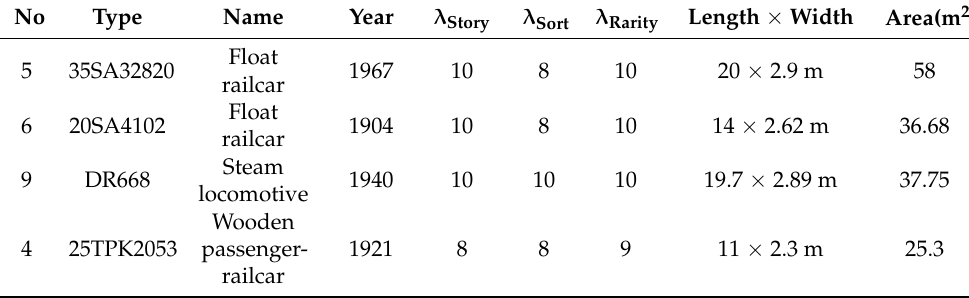
Table 9. After mutation of the layout instance (optimal